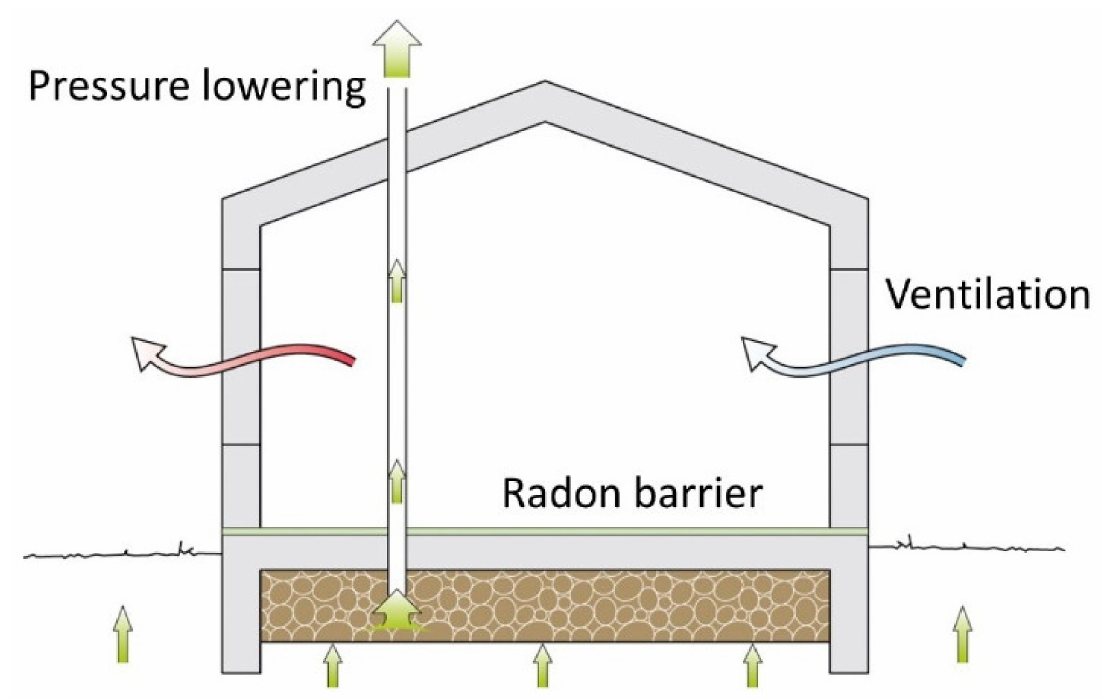
Figure 1. Design criteria to control the radon penetration and radon concentration in indoor